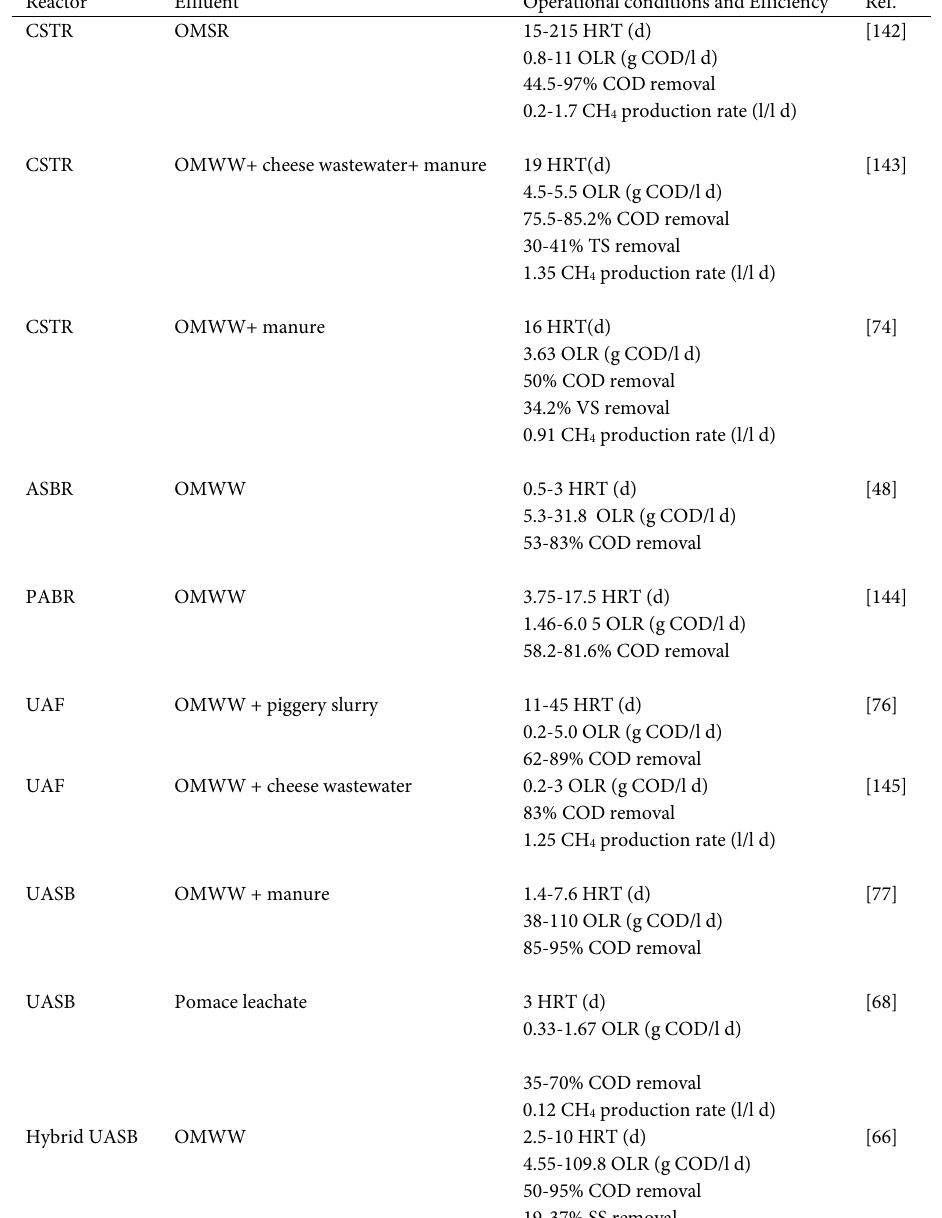
Table2. Performances of various anaerobic reactors in OMW treatment Table 3. Performances of various anaerobic reactors in OMW